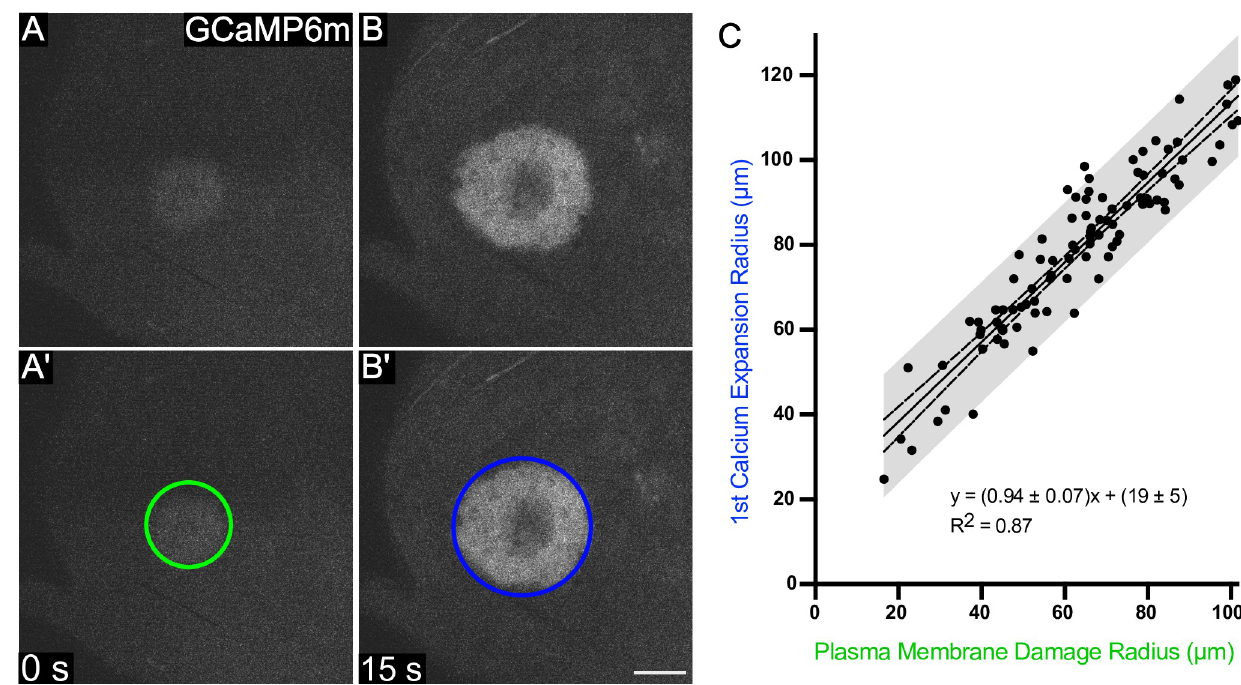
Fig 5. The first expansion of calcium extends about 20 μ m from the region of plasma membrane damage, independent of wound size. (A) The influx of calcium immediately after wounding identifies cells with plasma membrane damage. This region is observed by an immediate increase in GCaMP fluorescence, indicated by a green circle in A’. (B) The calcium radius increases over the next ~15 seconds [15], and the maximum first expansion region is indicated with a dark blue circle in panel B’. The relationship between the plasma membrane radius and the first expansion radius is linear. Because the slope is ~1, the y-intercept of 19 indicates that the 1 st expansion radius is expected to be ~20 μ m larger (~2 to 4 cell diameters) than the radius of plasma membrane damage, regardless of wound size or laser energy. n = 92 pupae. Scale bar = 50 μ